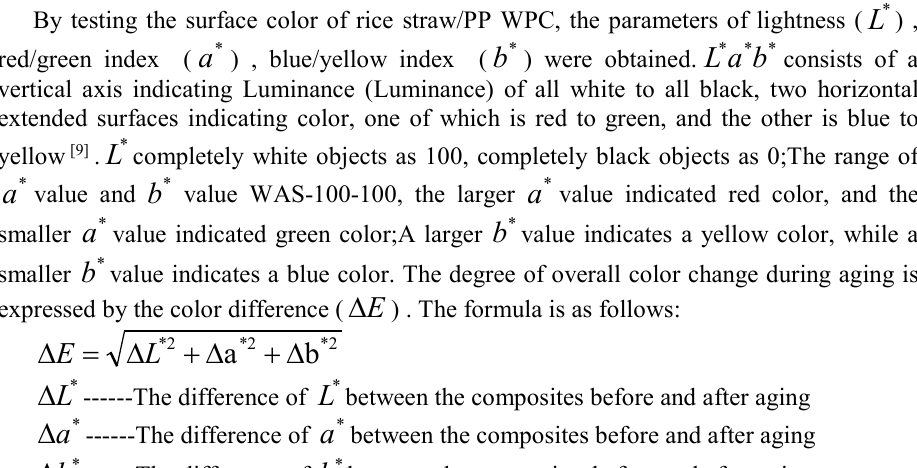
Fig. 1. Changes of surface lightness （ of composite